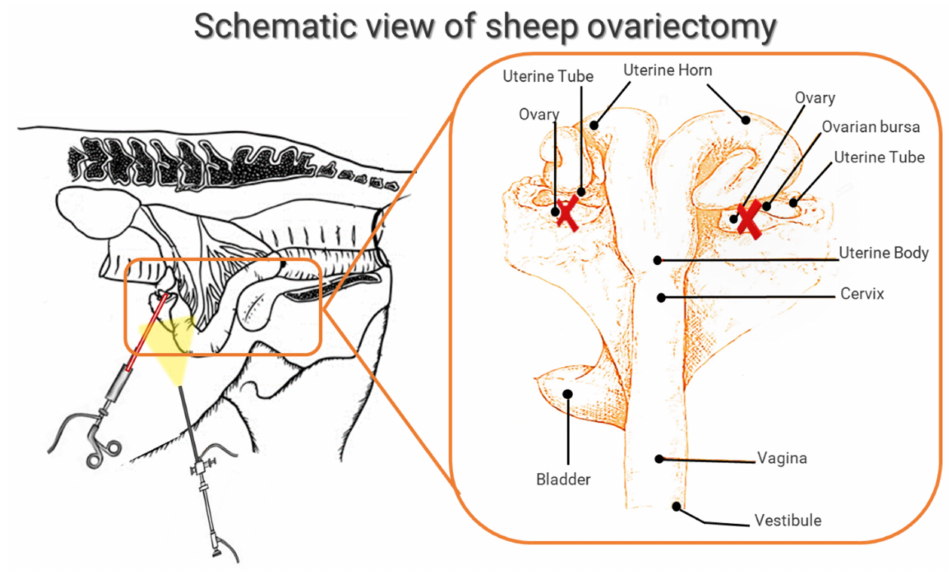
Figure 4. Schematic representation of bilateral OVX in sheep performed through a ventral midline laparotomy [41]. X: ovary